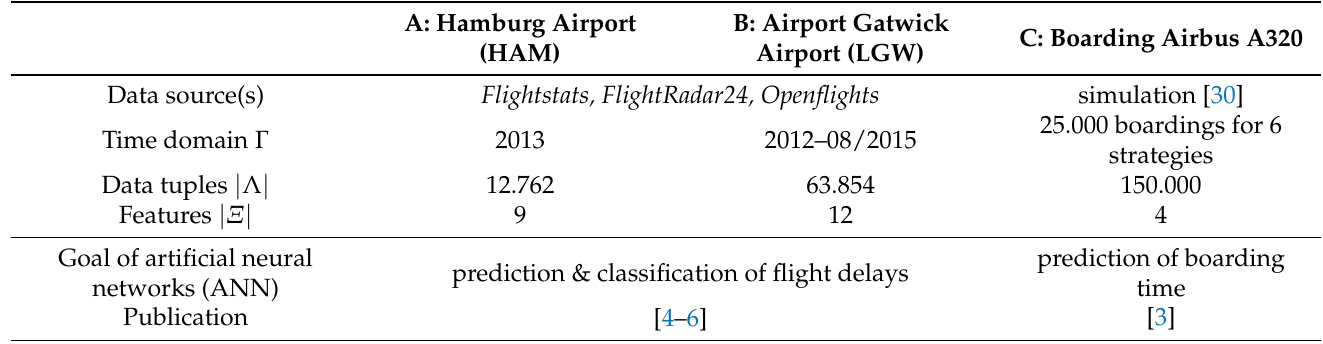
Table 1. Summary of the used ANN with different uses cases at airports HAM and LGW, as well as boarding of an Airbus A320.